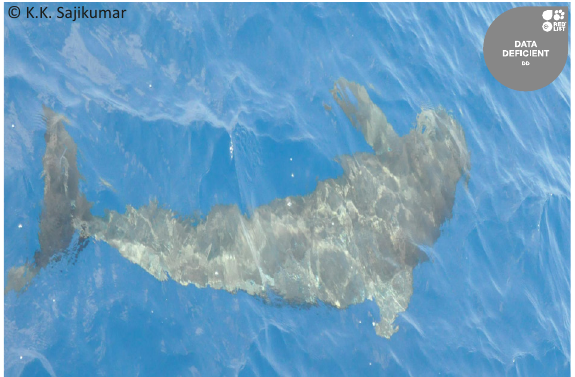
Image 4. Whale showing side rolling behaviour.